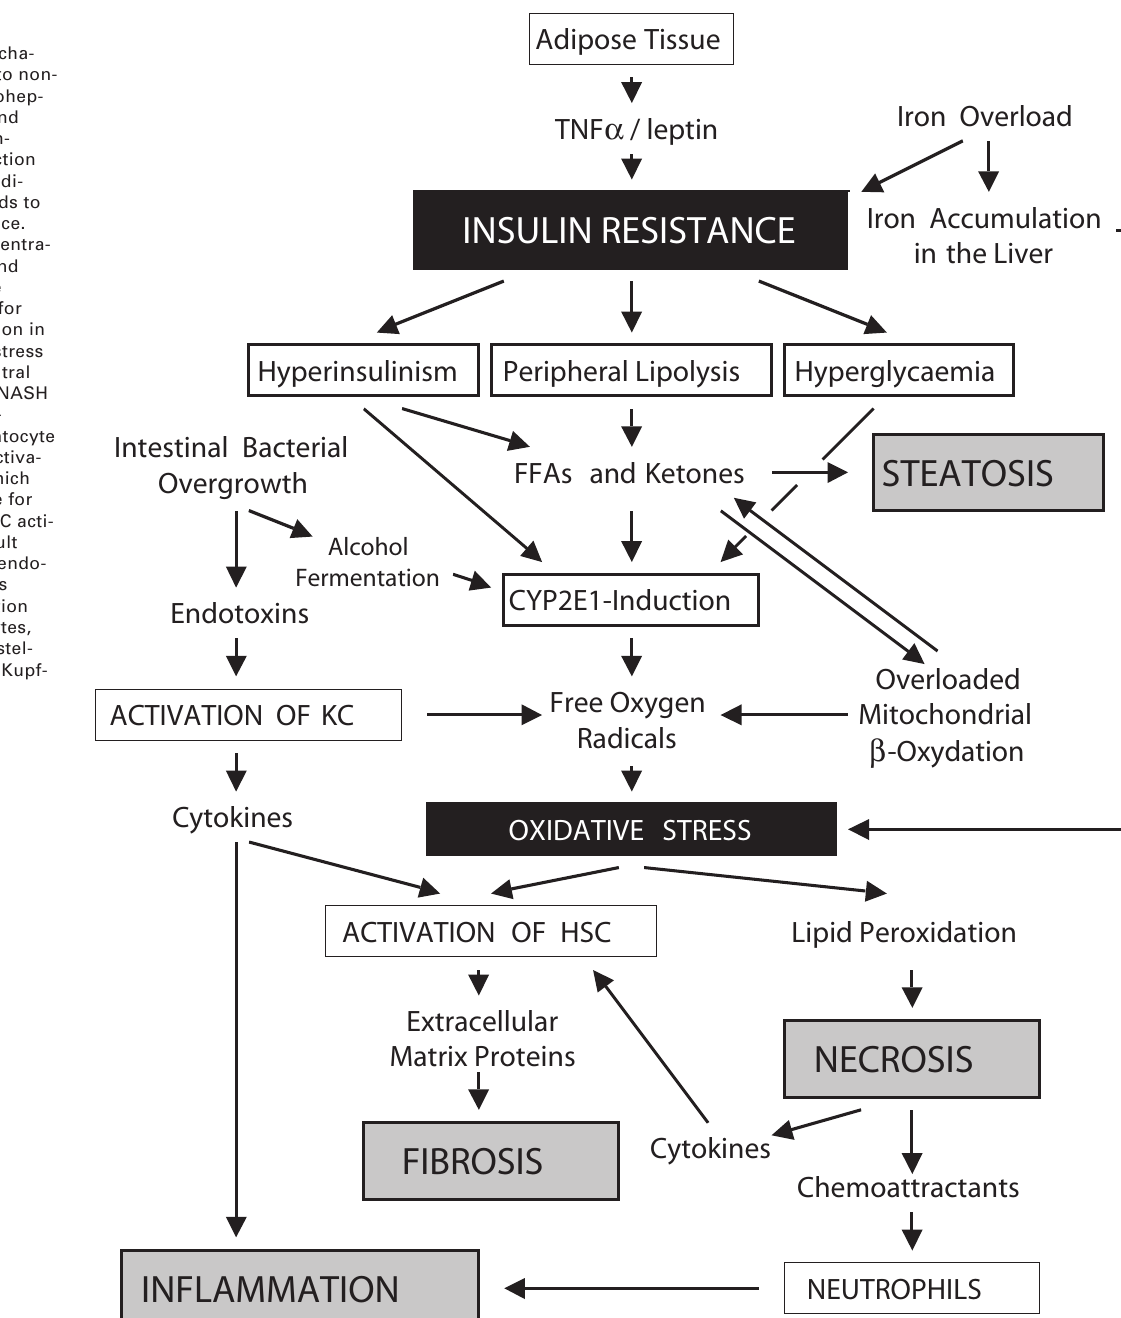
Figure 1 Pathogenic mecha- nisms leading to non- alcoholic steatohep- atitis (NASH) and liver fibrosis. In- creased production of TNF a from adi- pose tissue leads to insulin resistance. Enhanced concentra- tions of FFAs and ketones are the main stimulus for CYP2E1-induction in HC. Oxidative stress occurs as a central mechanism in NASH with the conse- quence of hepatocyte necrosis and activa- tion of HSC, which are responsible for liver fibrosis. KC acti- vation as a result of gut-derived endo- toxins produces liver inflammation [HC = hepatocytes, HSC = hepatic stel- late cells, KC = Kupf- fer